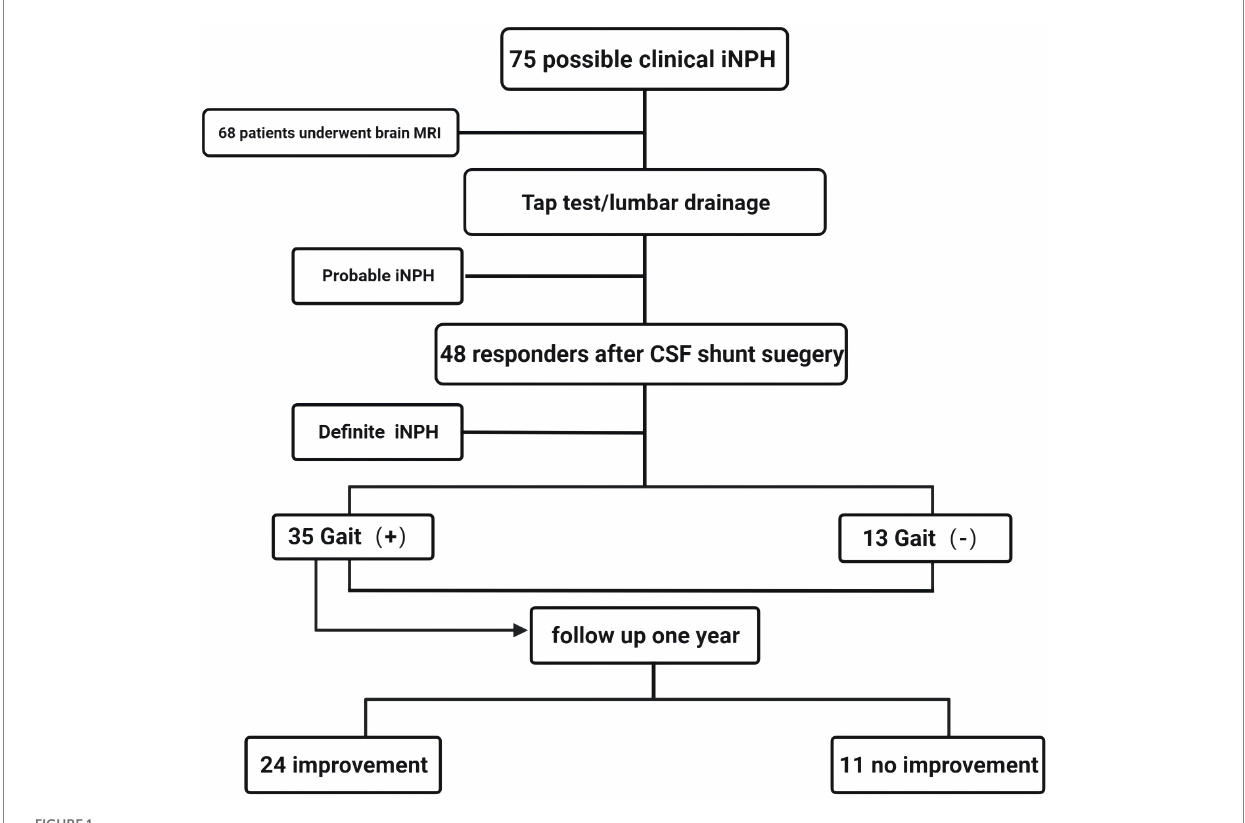
FIGURE 1 Flow chart of iNPH patient inclusion, evaluation, and